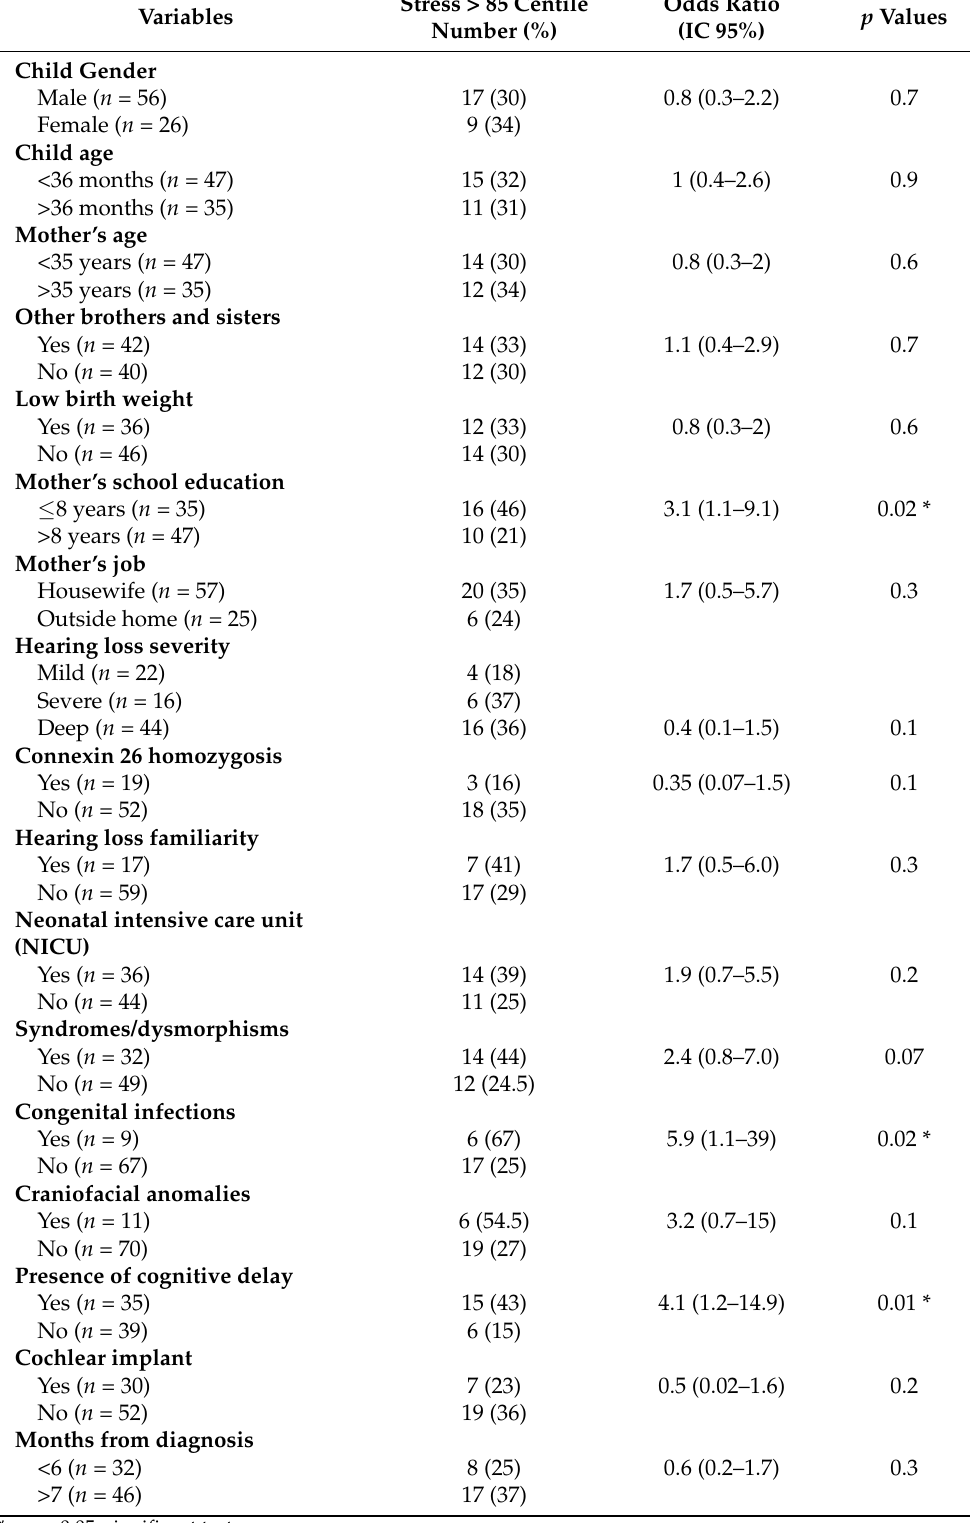
Table 2. Univariate associations between child’s and family’s characteristics with overall stress.